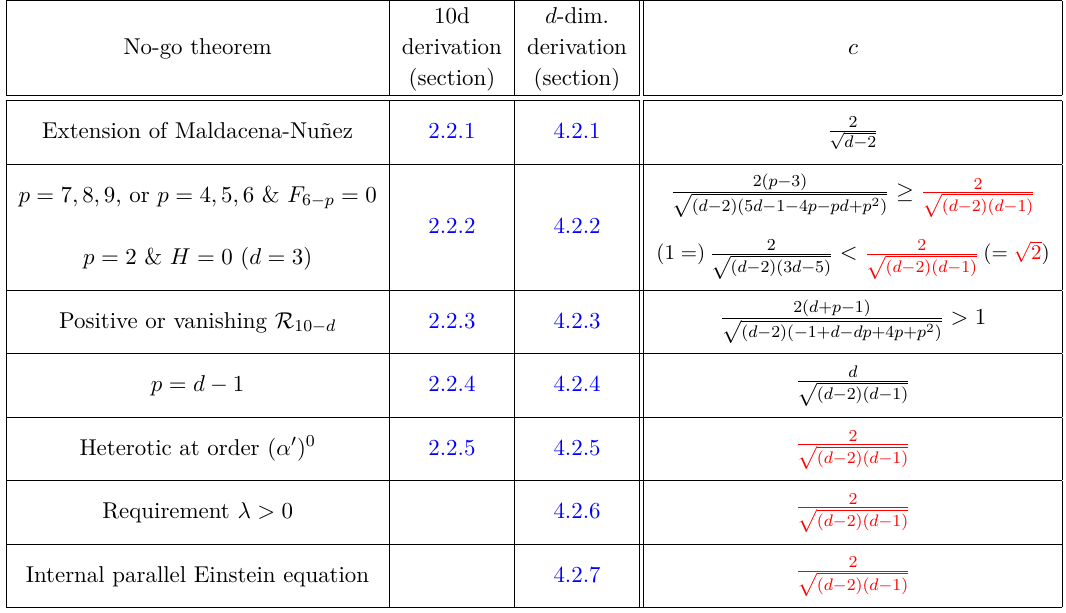
Table 4 . No-go theorems considered in the paper, with the sections where they were derived, using the 10d approach or the d -dimensional one. The latter, giving an inequality of the form (4.36), leads to a ( d -dependent) c value, reported in the last column. The values corresponding to the TCC bound (4.37) are highlighted in